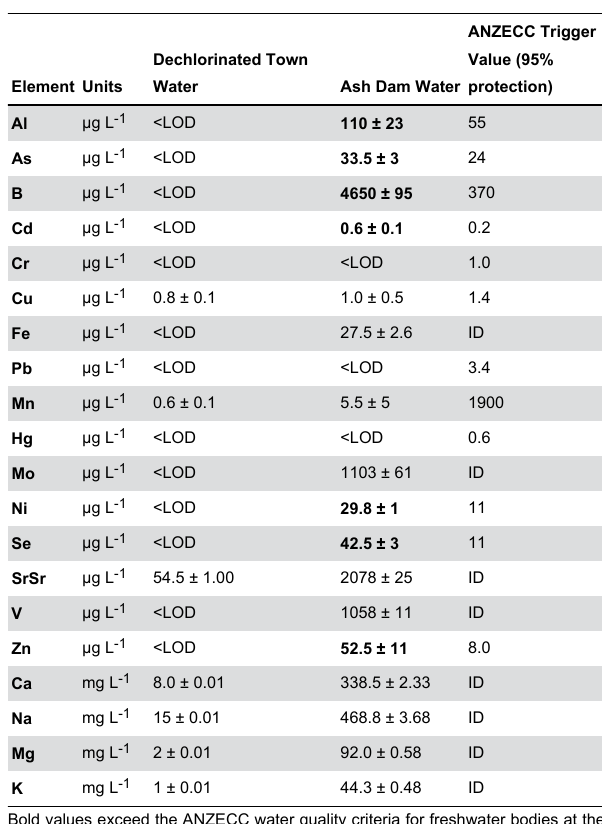
Table 1. Concentration of metals, metalloids and other elements in Dechlorinated Town Water and Ash Dam